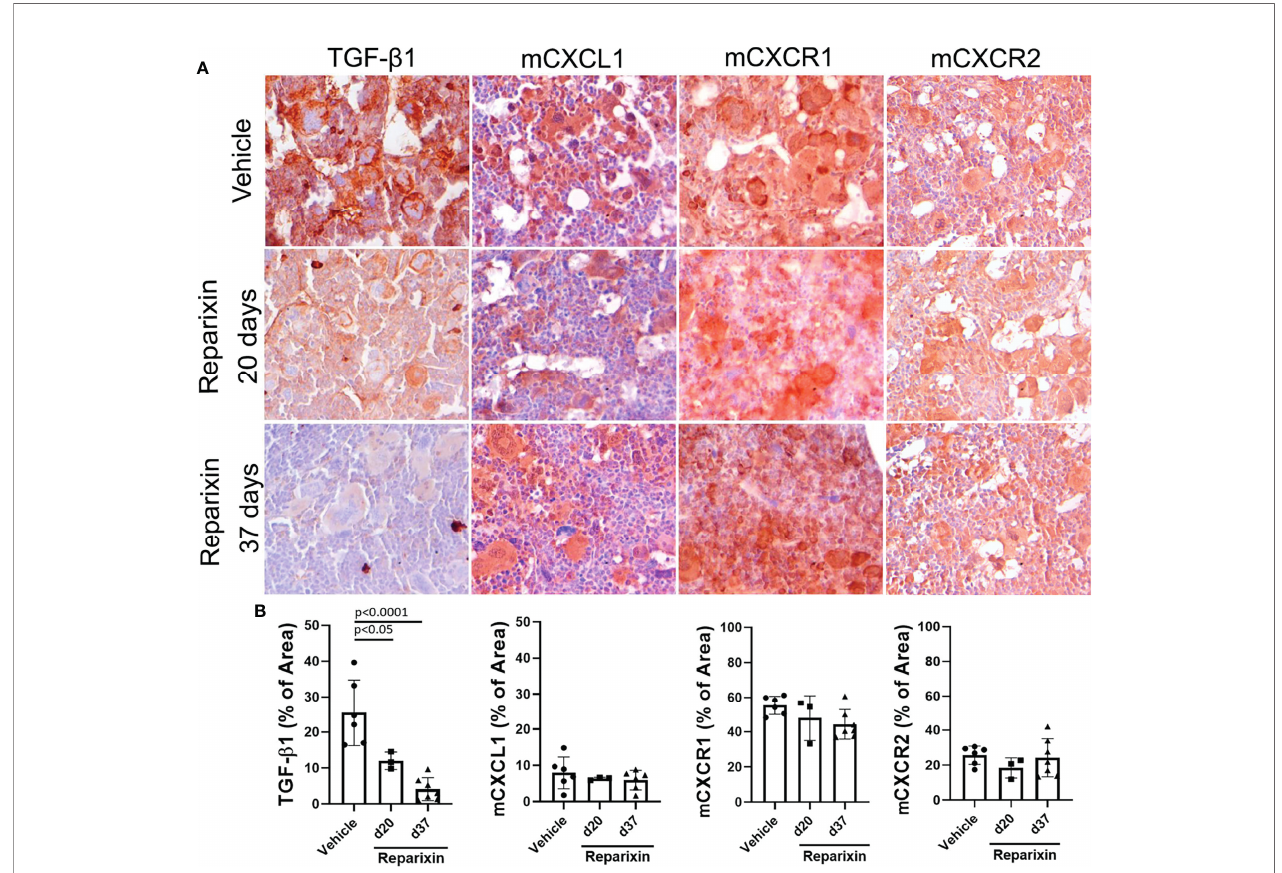
FIGURE 6 | Treatment with Reparixin decreases the TGF- b 1 content of the BM from Gata1 low mice. (A) Immunohistochemical staining for TGF- b 1, mCXCL1, mCXCR1, and mCXCR2 of BM sections from representative Gata1 low mice treated either with vehicle or Reparixin for 20 or 37 days, as indicated. Magni fi cations ×40. (B) Quanti fi cation by computer assisted imaging of the TGF- b 1, mCXCL1, mCXCR1, and mCXCR2 content in the BM from Gata1low mice treated with either with vehicle or Reparixin for 20 or 37 days, as indicated. Data are presented as Mean (± SD) and were analyzed by Tukey ’ s multiple comparisons test. Values observed in individual mice are presented as dots. P < 0.05 were considered statistically signi fi